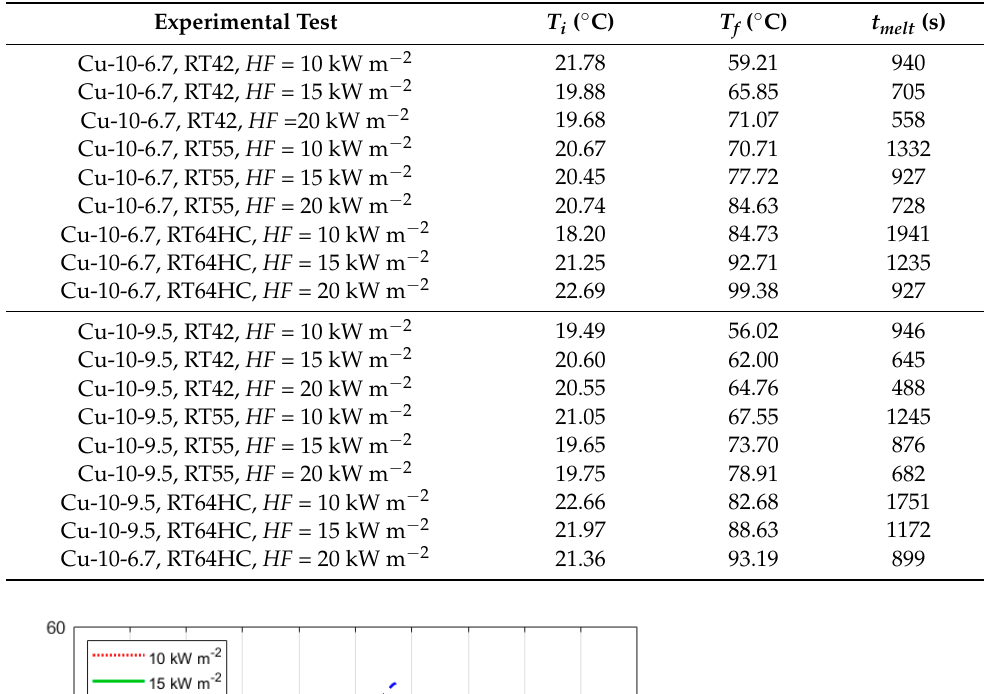
Table 3. Summary of the experimental results.